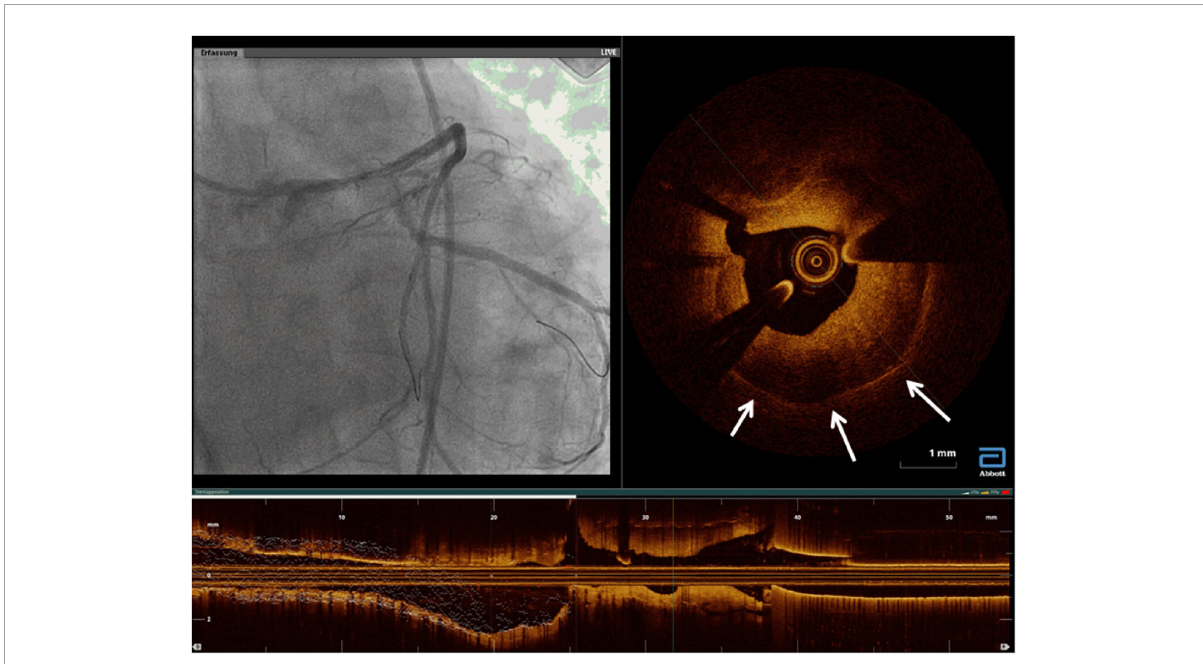
FIGURE13 A case of rapidly growing in-stent restenosis of the left main (3 months from previous angiography). The white arrows mark areas of peri-strut low-intensity compatible with inflammatory processes and with a rapid progression of